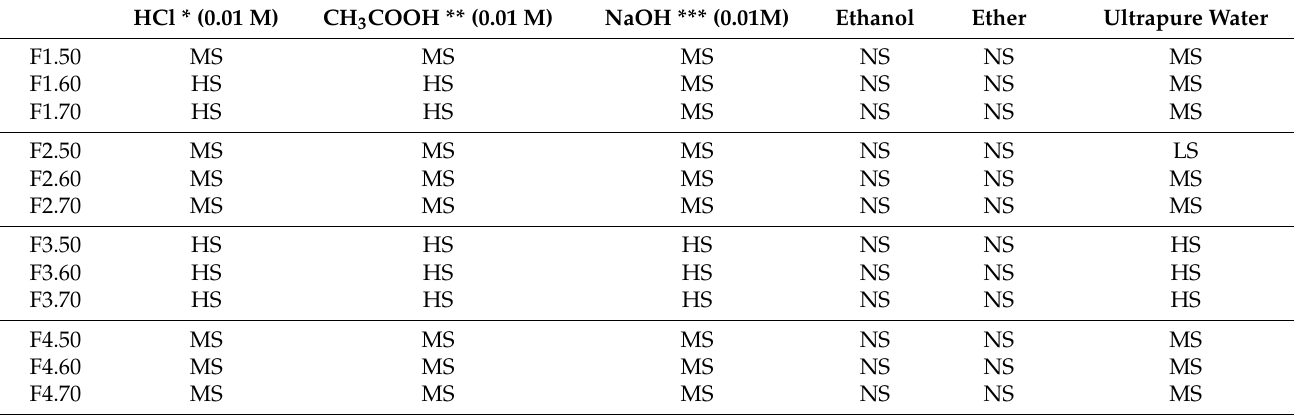
Table 3. Solubility resistance in edible